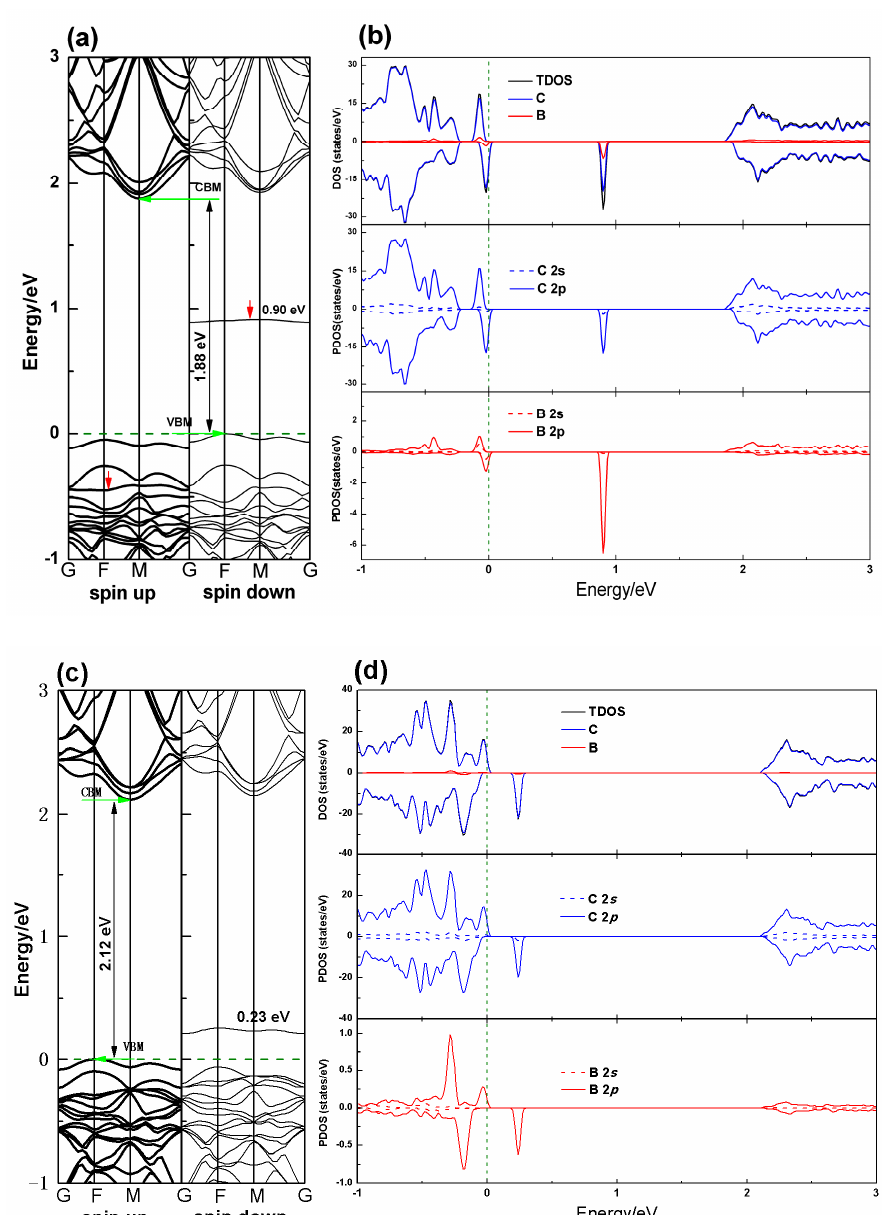
Figure 3. Calculated electronic energy band structure, TDOS and PDOS of the PG–B (sp 2 ) (( a ) and ( b )) and PG–B (sp 3 ) (( c ) and ( d )) systems. The black solid line in the density of states plot shows the TDOS of the system. The blue and red lines indicate the PDOS of carbon and boron atoms, respectively. The olive dash lines represent the Fermi energy level.